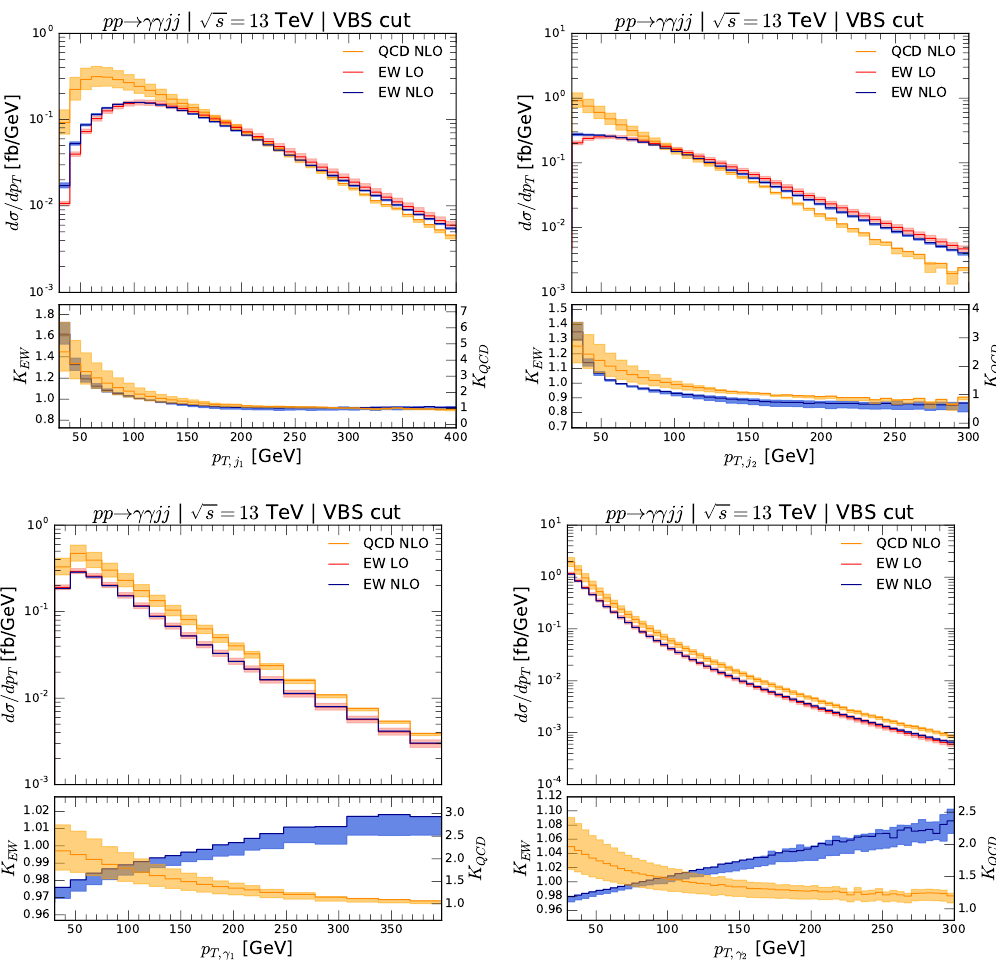
Figure 5 . Distributions of the transverse momentum of the hardest jet (top left), the second- hardest jet (top right), the hardest photon (bottom left) and the second-hardest photon (bot- tom